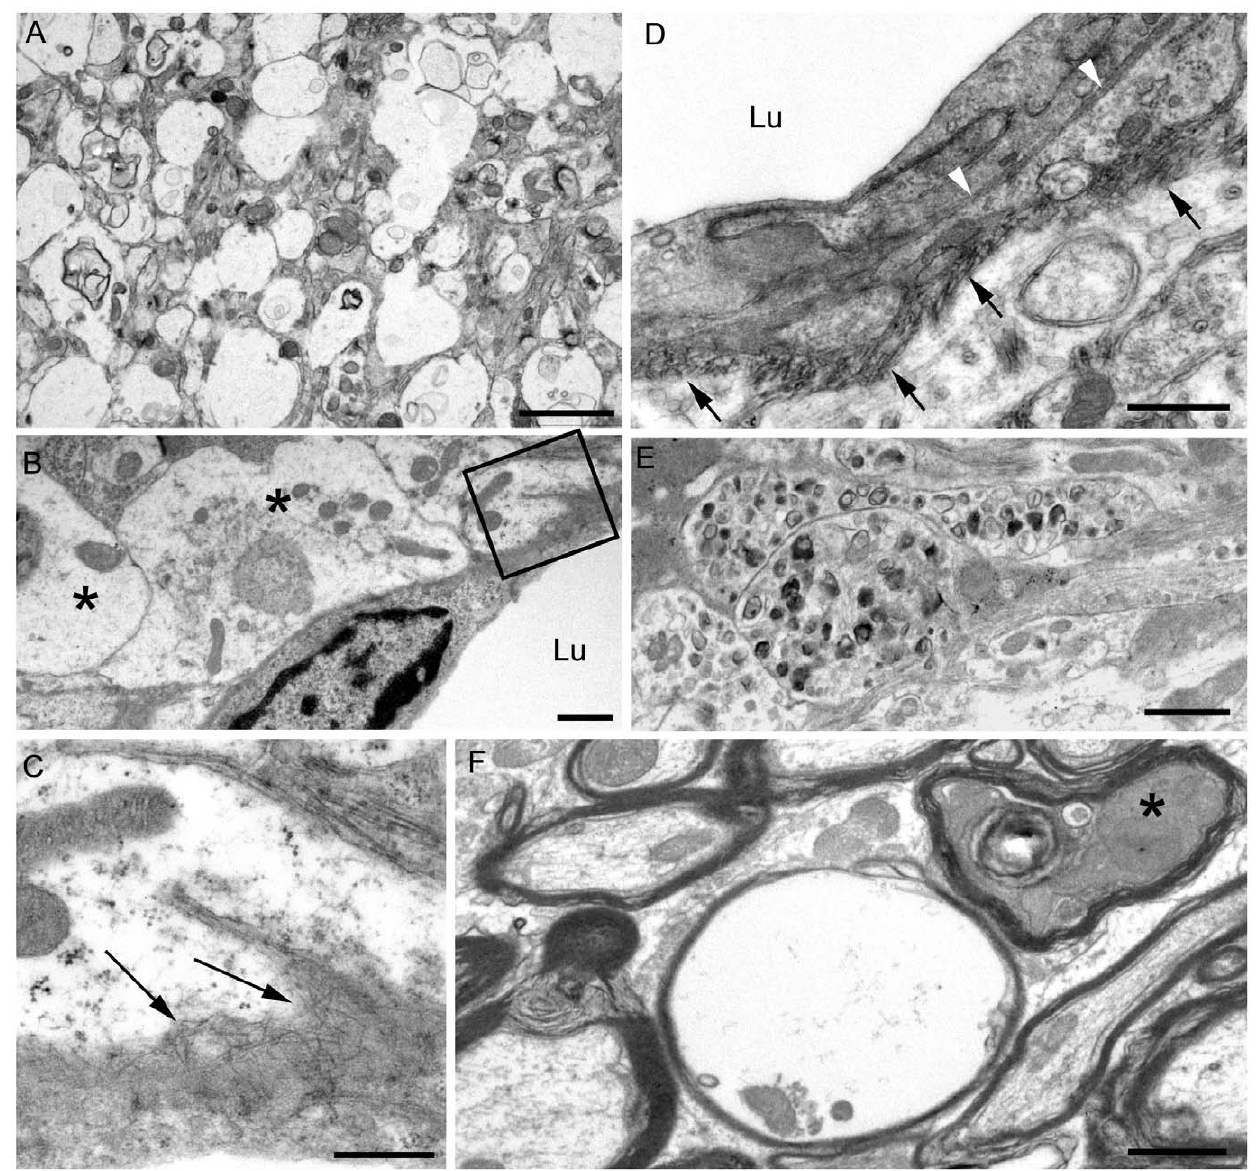
Figure 6. Ultrastructure of cerebral cortex and cerebellum of a 22L scrapie-infected tg44 + / + mouse. Sections were from same mouse as shown in Figure 5, and were stained with uranyl acetate/lead citrate. (A) Area of neuropil with severe vacuolation where most vacuoles originate within processes and are separated from each other by intact membranes. (B) Several distended astrocytic processes (asterisks) of the perivascular glial limitans are present around a blood vessel Lu: lumen. (C) On higher magnification of boxed area from (B), the endothelial basement is shown to be filled with irregularly orientated amyloid fibrils (arrows). (D) The earliest stage of vascular amyloid is shown. Here the endothelial basement membrane (black arrowheads) is intact, but the pericyte basement membrane (black arrows) is thickened and heavily infiltrated with short amyloid fibrils (white arrowheads). (E) Severe neuritic dystrophy in which several processes show an excessive accumulation of organelles and abnormal electron dense bodies. (F) White matter of the cerebellum showing an empty myelin sheath (seen as vacuoles by light microscopy) and also a dark degenerate axon (asterisk) within an intact myelin sheath. Similar findings were observed in RML scrapie-infected tg44 + / + mice. Scale bars: A, 2 m m; B, E, F, 1 m m; C, 500 nm; D, 500